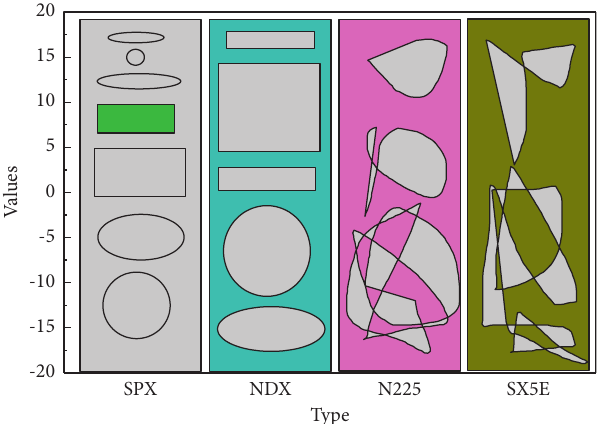
Figure 3: Box plot of percentage change in airline-related